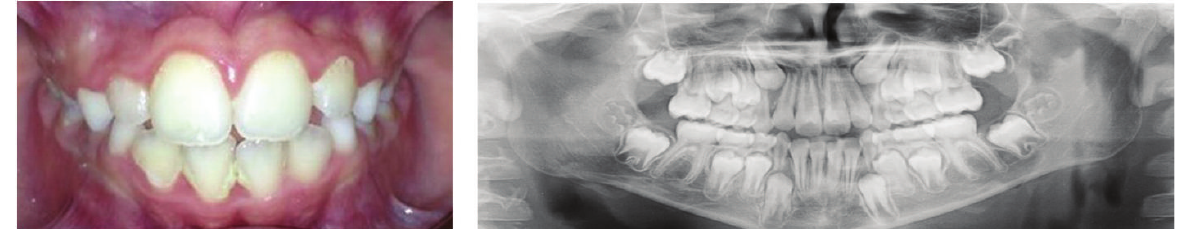
Figure 5: Permanent maxillary incisors normally erupted after an 8-year follow-up.